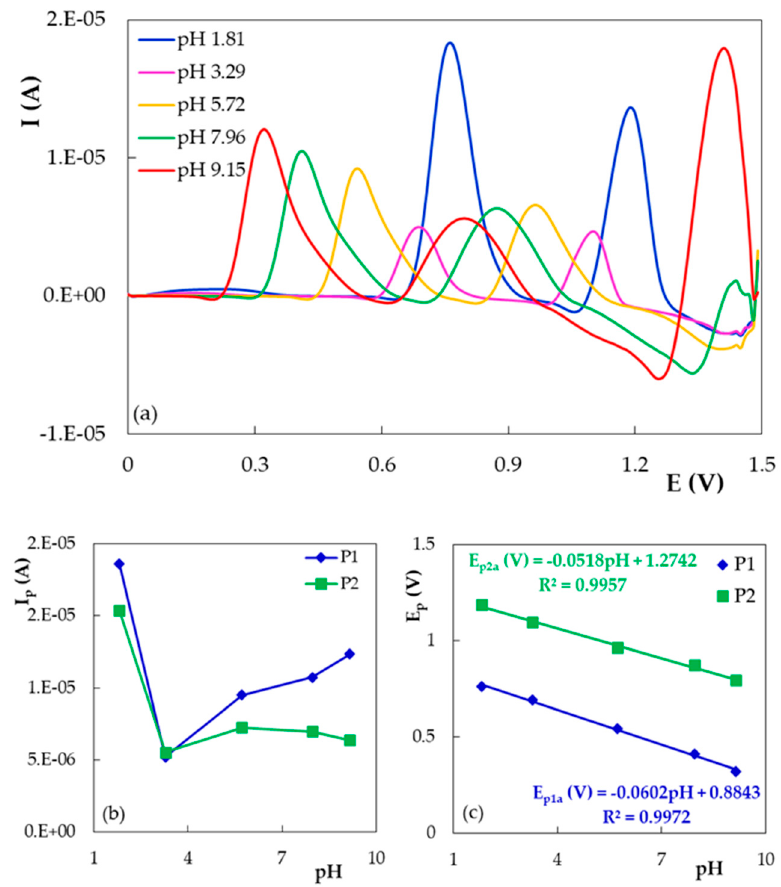
Figure 3. ( a ) Differential pulse voltammograms recorded on PGE_H for 5.00 × 10 − 5 mol/L DIO in BRB solution with different pH values. ( b ) The variation of the DIO DPV peak currents with the solution pH. ( c ) The DIO DPV peak potential dependencies on the solution pH.